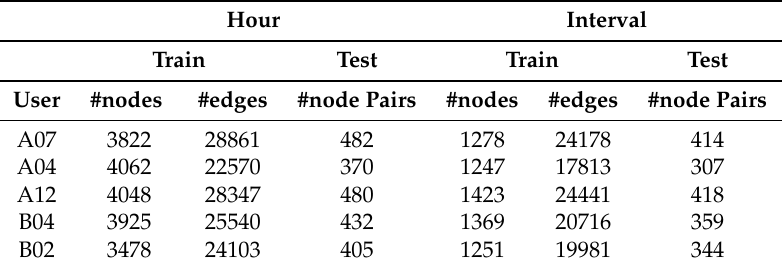
Table 2. Statistics of the network dataset for